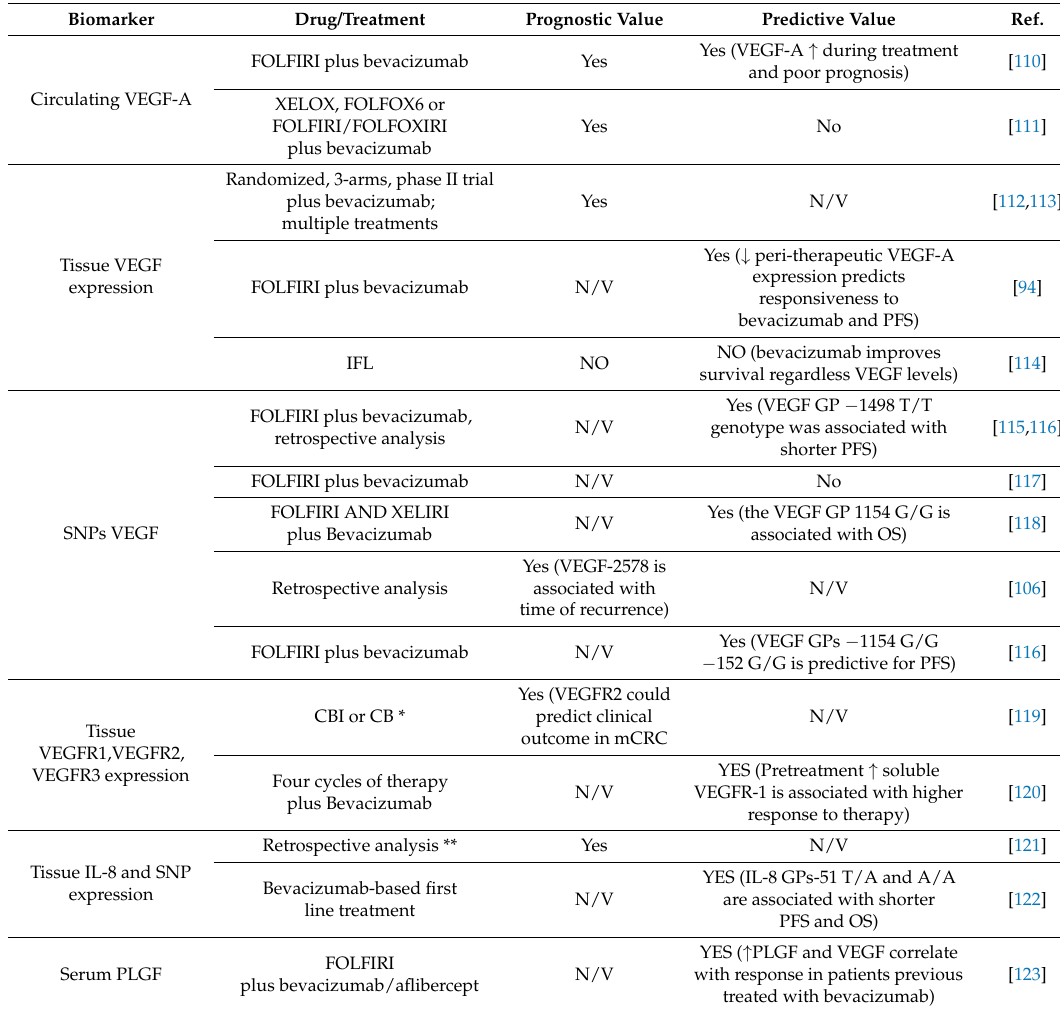
Table 2. Prognostic and predictive biomarkers proposed for advanced CRC and validated by clinical